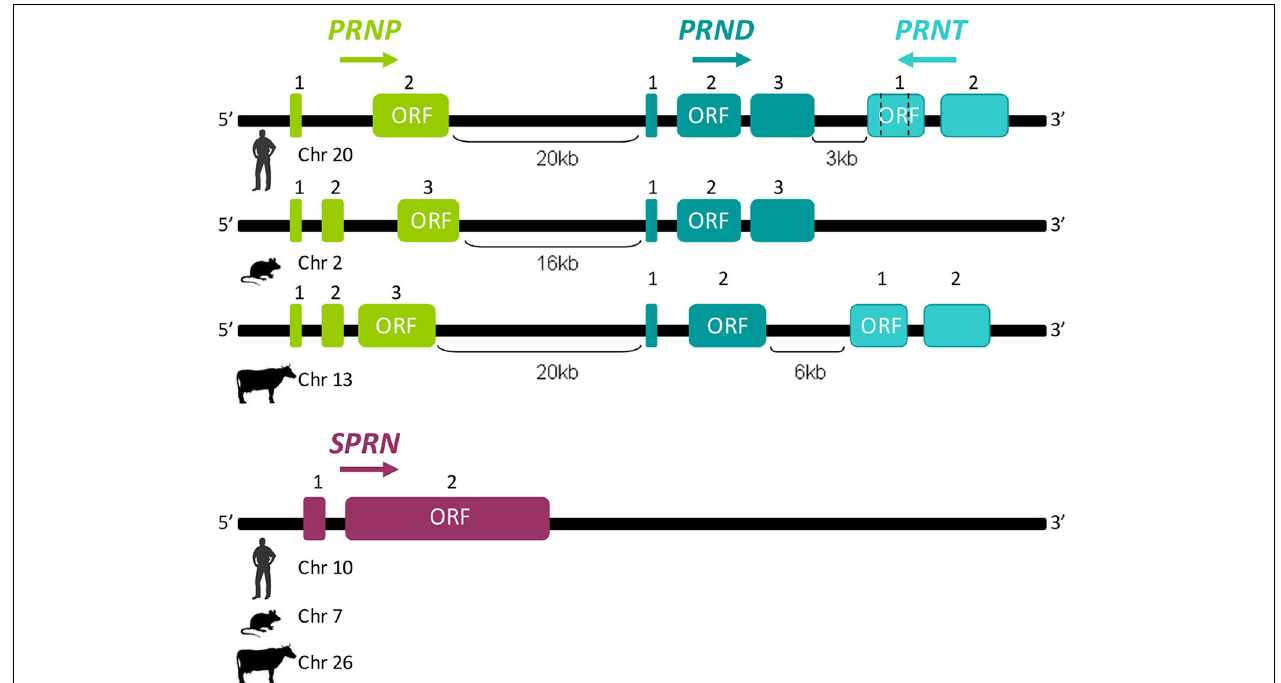
FIGURE 2 | Schematic structural representation of prion genes family members. PRNP , PRND, and PRNT are clustered on the same genomic locus. The distance between PRNP , PRND, and PRNT are given in kilobases (kb); according to species, the number of exons could be variable. SPRN